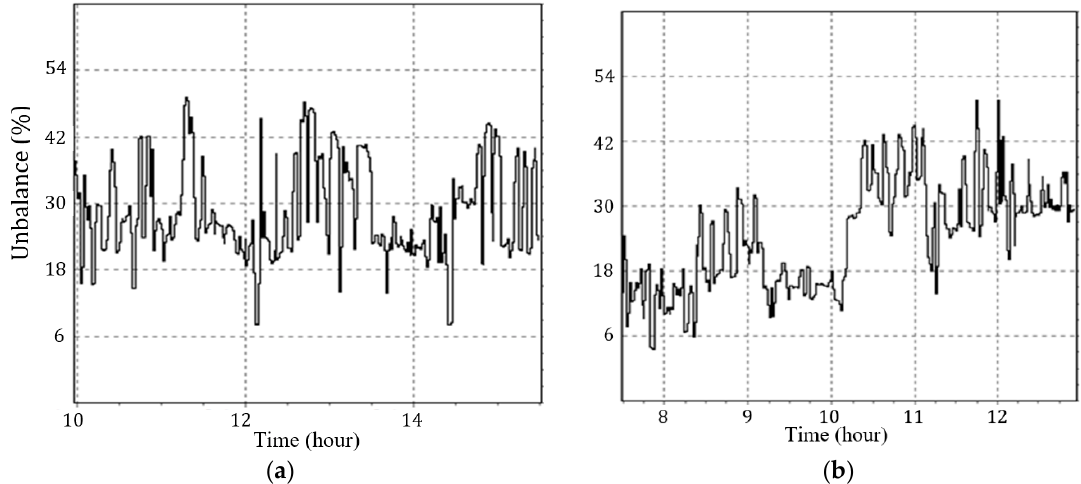
Figure 5. The load unbalance reflected by the neutral wire current: ( a ) during the first period (9 January 2020); ( b ) during the second period (10 January 2020).